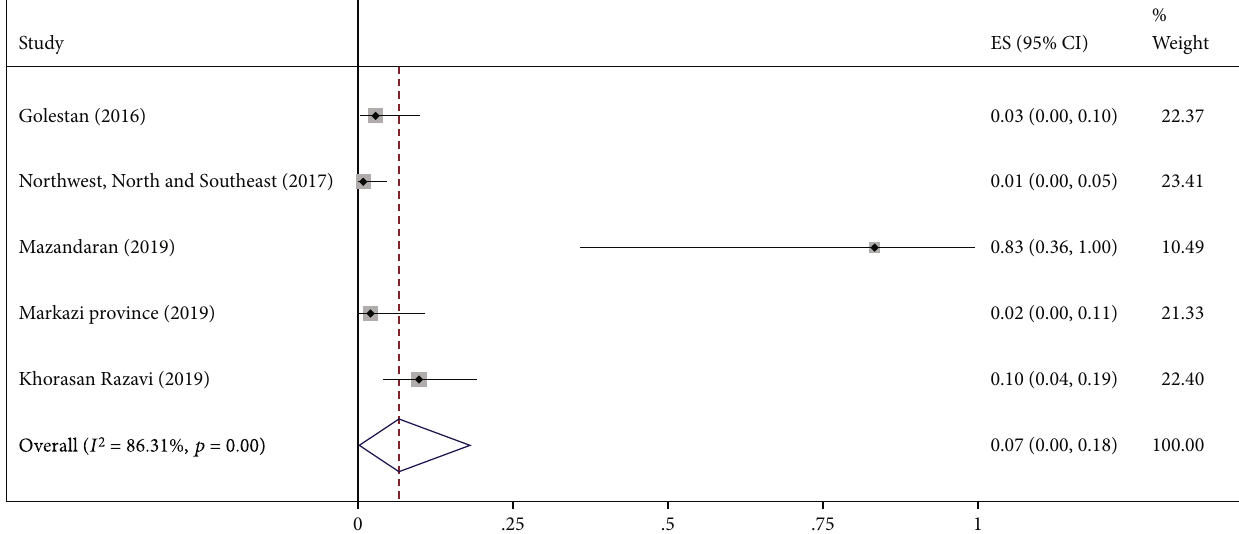
genotype prevalence in animals. 2